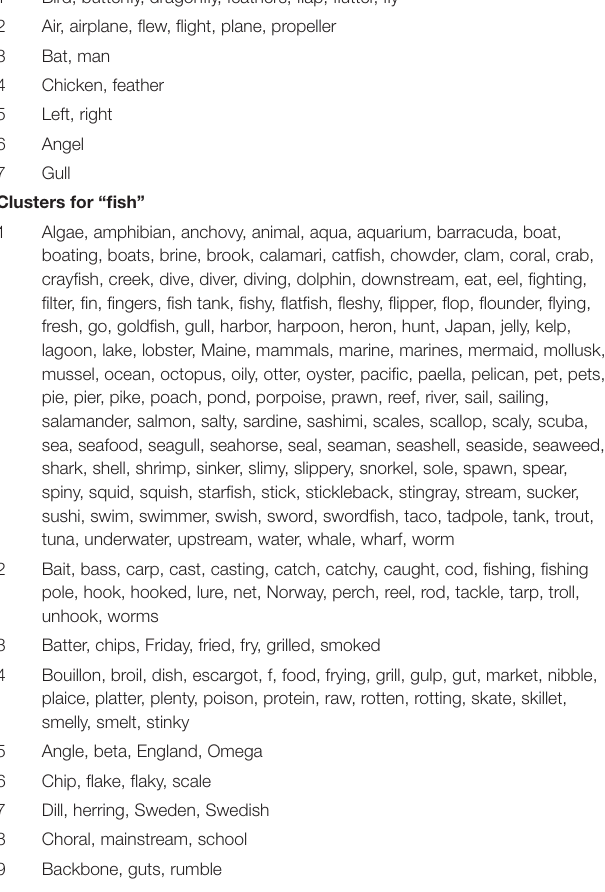
TABLE 4 | Girvan-Newman cluster analysis of the Small World of Words dataset. Clusters for “wing”